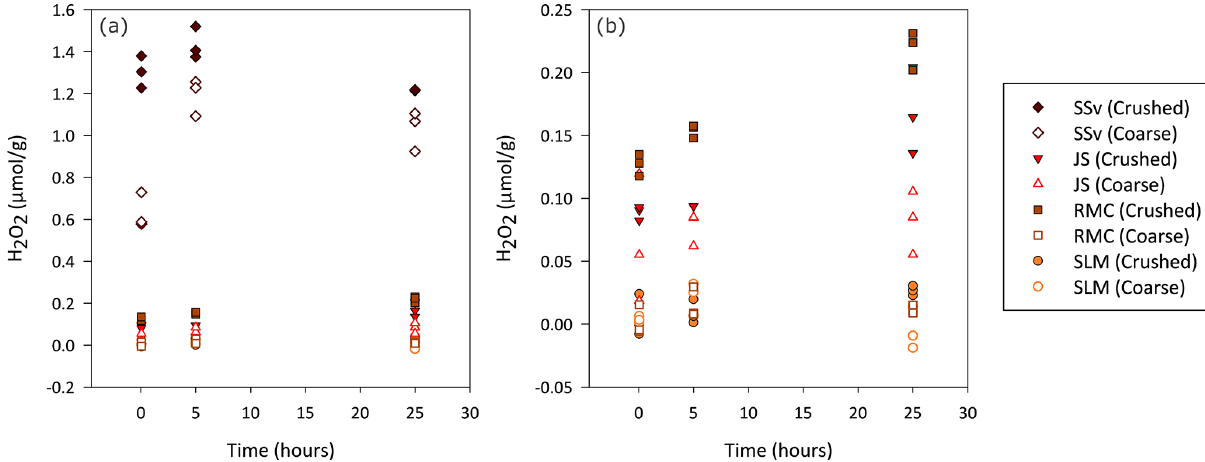
Figure 1. Concentration of H 2 O 2 generated by coarse and crushed sedimentary rock (SSv, JS and RMC) and subglacial sediment sam- ples (SLM). (a) Blank-corrected H 2 O 2 (µmol) produced per gram of crushed and coarse samples during a 25h aerobic incubation of these samples with water. (b) Focus on lower concentrations of H 2 O 2 , excluding results of coarse and crushed SSv samples, to allow a clearer view of the data distribution of the remaining samples.